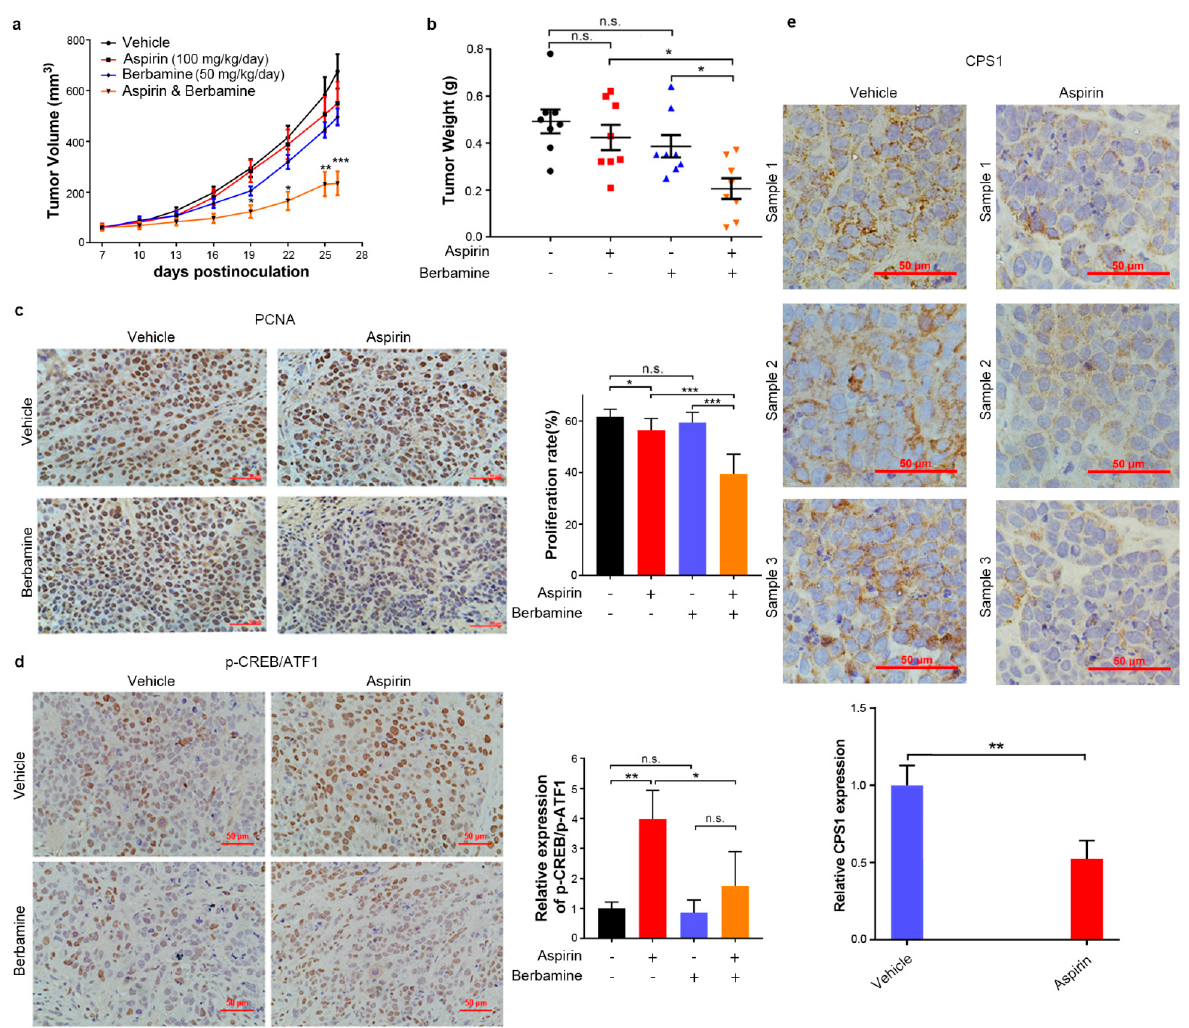
Figure 7. Combined treatment with aspirin and berbamine inhibits HepG2 xenograft tumors in nude mice. ( a ) BALB/c-nu mice with HepG2 xenografts were treated with or without aspirin and/or berbamine. The tumor growth curves were plotted. Values represent means ± SD ( n = 8). *, p < 0.05, **, p < 0.01, ***, p < 0.001, compared with tumors treated with berbamine alone. ( b ) The tumor weight was plotted. Values represent means ± SD ( n = 8). *, p < 0.05. n.s., not significant. ( c ) Immunohistochemical staining of PCNA in tumor tissue sections. The proliferation rate was plotted. *, p < 0.05, ***, p < 0.001. ( d ) Immunohistochemical analysis of CREB/ATF1 phosphorylation in tumor tissue sections. The relative CREB/ATF1 phosphorylation was plotted. n.s. , not significant. *, p < 0.05, **, p < 0.01. ( e ) Immunohistochemical staining of CPS1 in tumor tissue sections. Representative immunohistochemical staining of vehicle- or aspirin-treated tumors was shown. Scale bar , 50 µ m. The relative CPS1 expression was plotted. **, p <